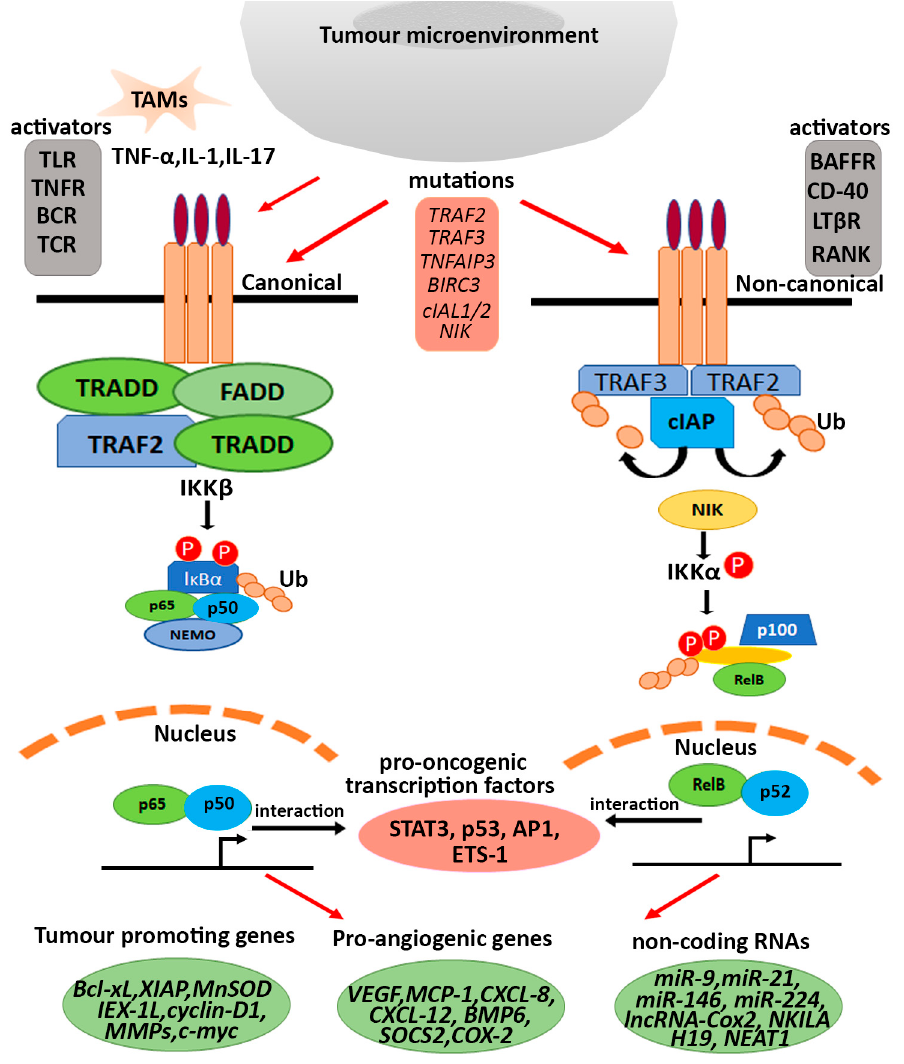
Figure 1. Aberrant activation and transcriptional regulation of NF- κ B pathway in cancer. In addition to constitutive activator molecules of both the canonical and non-canonical NF- κ B pathway (highlighted in grey box), activation of the NF- κ B pathway in cancer occurs via various other factors involving cytokines like TNF- α , IL-1, IL-17 secreted by tumour-associated macrophages (TAMs) and oncogenic driver mutations in various regulatory factors of the pathway (highlighted in pink box). Upon such activation, the activated NF- κ B subunits interact with pro-tumorigenic transcription factors (highlighted in red oval), causing activation of alternative target genes associated with tumour promotion phenotypes, angiogenesis and tumour-associated non-coding RNAs.